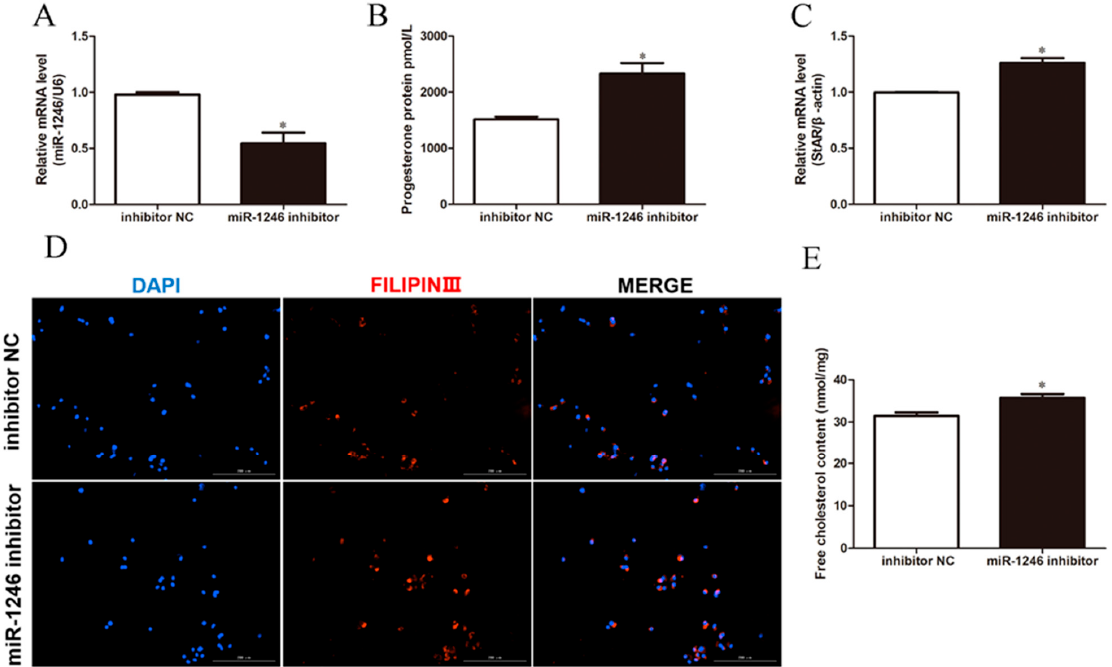
Figure 3. Underexpression of miR-1246 promotes P4 synthesis in BGCs. ( A ) The level of P4 in BGCs. ( B , C ) Relative mRNA expression of StAR and miR-1246 in BGCs. ( D ) Representative filipin staining of BGCs. ( E ) Relative content of free cholesterol in BGCs. Inhibitor NC, negative control of miR-1246 inhibitor; miR-1246 inhibitor, underexpression of miR-1246. All data were presented as the mean ± SD ( n = 3), * p <